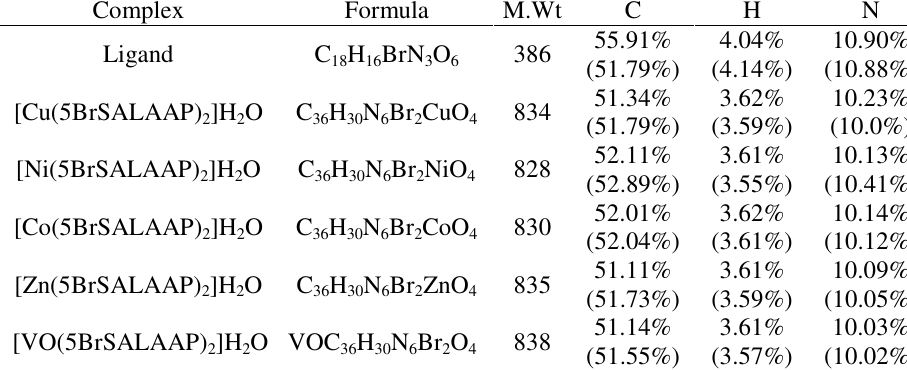
Table 1. Analytical data of complexes